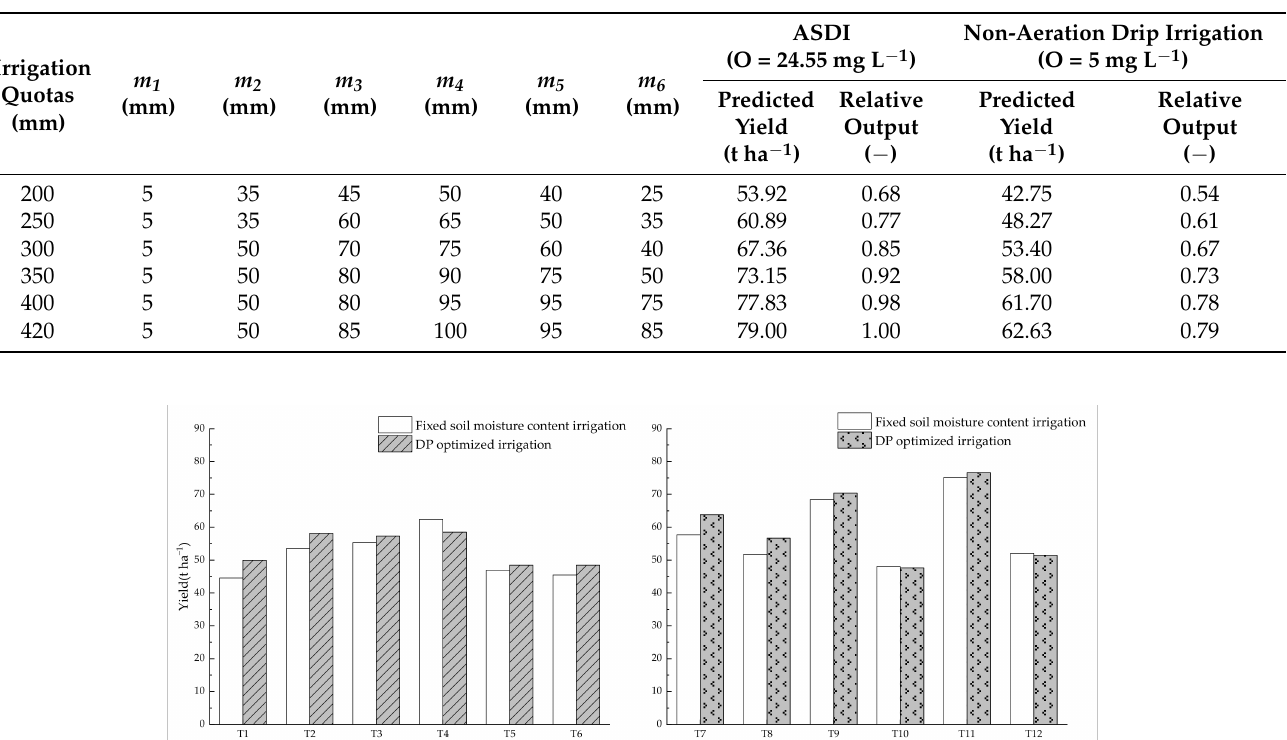
Table 7. Optimal irrigation scheme with multiple irrigation quotas.